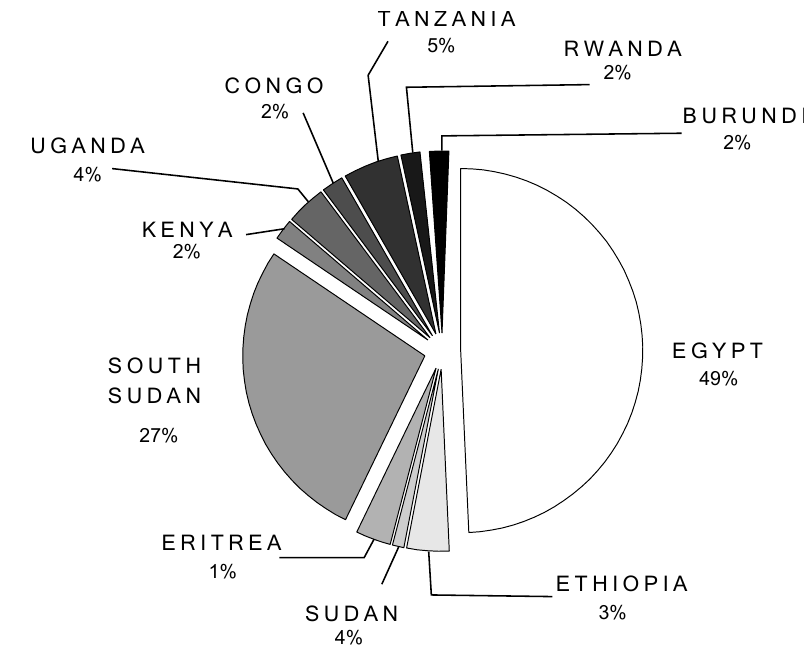
Figure 3. Percentages of contribution in cooperation.